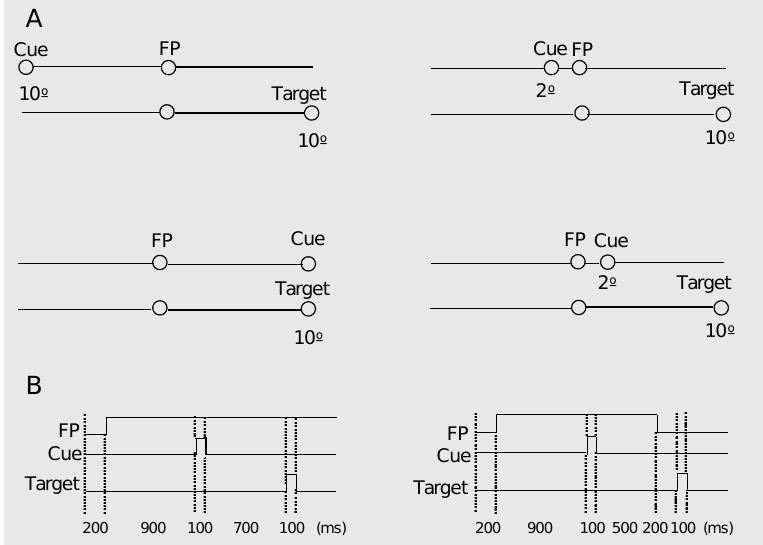
Figure 1. Schematic diagram and temporal sequence of events during trials. A , Relative positions of the fixation point (FP) when the cue occurred: 1 , 10 º on the left and the target was presented 10 º on the right (cue and target in opposite hemifields), 2 , 2 º on the left and the target was presented 10 º on the right (cue and target in opposite hemifields), 3 , 10 º on the right and the target was presented 10 º on the right (cue and target at the same position), 4 , 2 º on the right and the target was presented 10 º at right (cue and target in the same hemifield, but in different locations). B , Temporal sequence of events: the overlap paradigm in which the FP remains on throughout the trial is illustrated on the left and the gap paradigm in which the FP is turned off 200 ms before the appearance of the target is illustrated on the